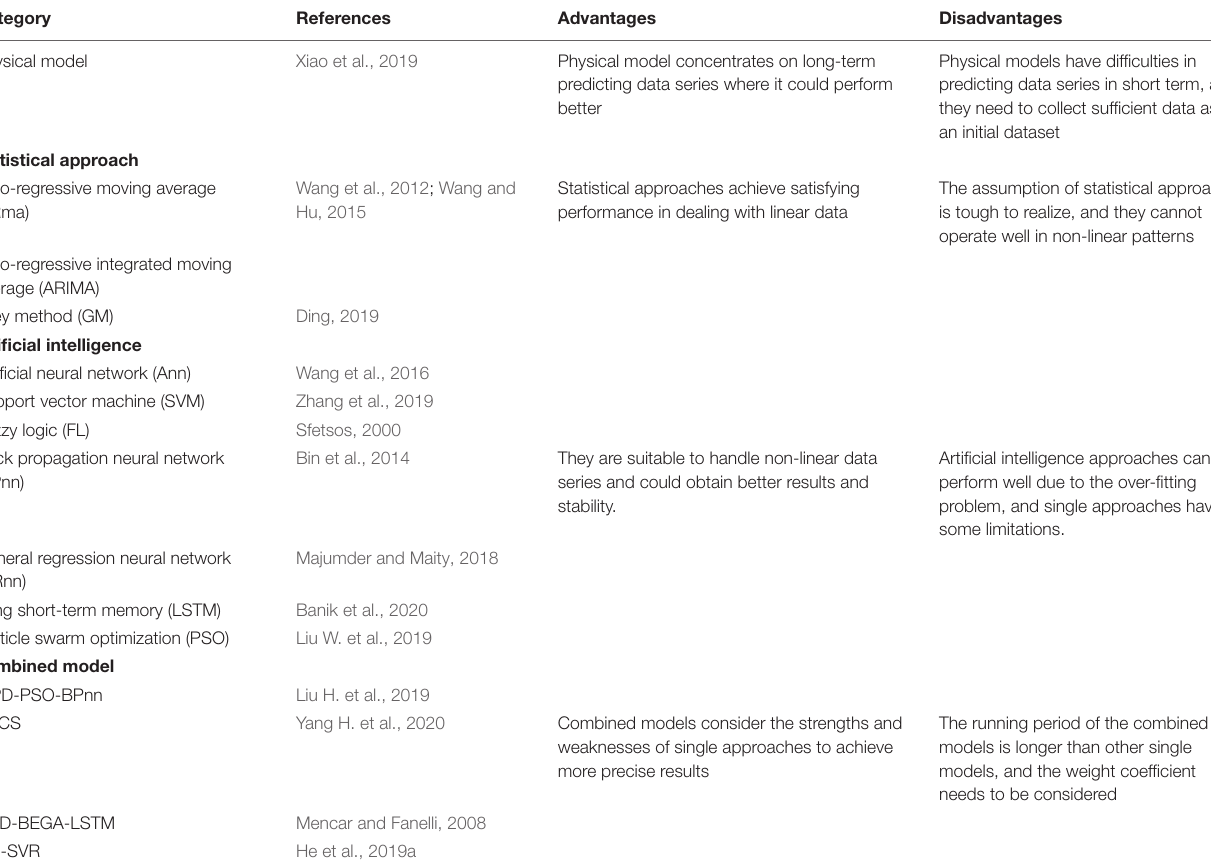
TABLE 1 | Summary of predicting approach